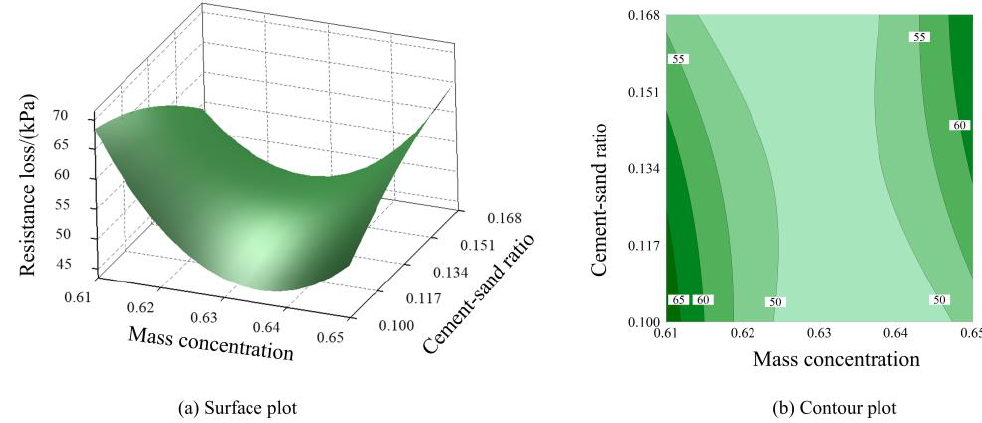
Figure 8. Interaction of mass concentration and cement – sand ratio with resistance loss: the other factor is held at the center level.